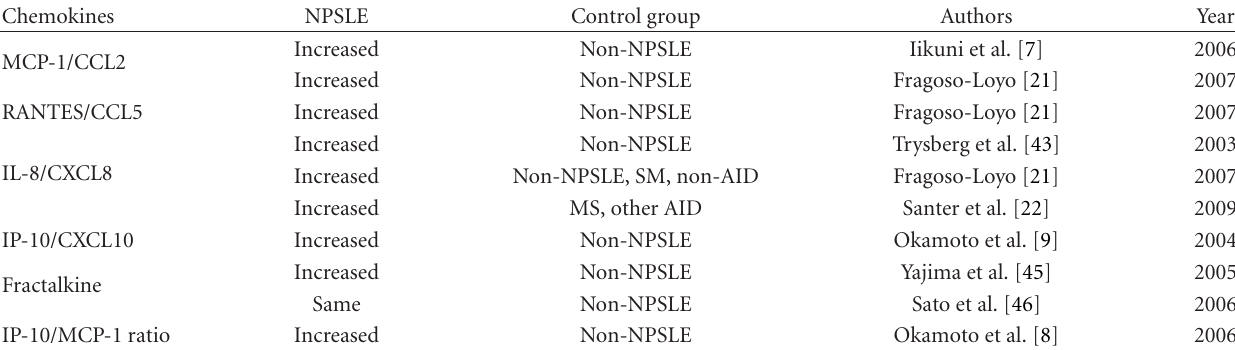
Table 3: CHemokines in CSF of